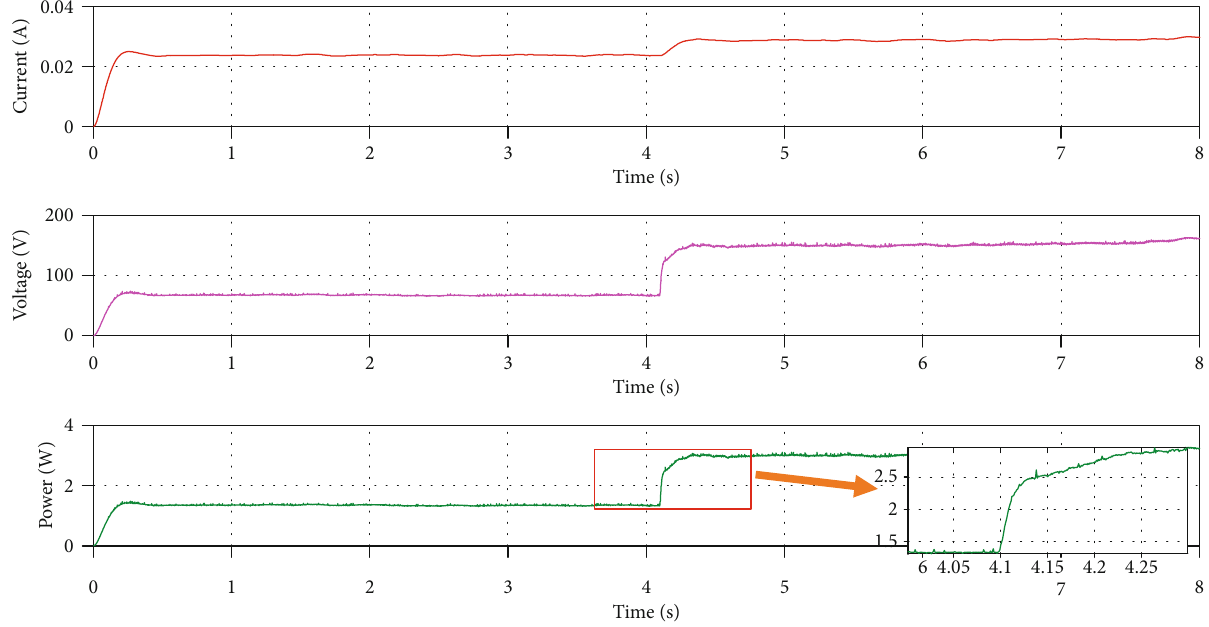
Figure 21: Experimental results (current, voltage, and power) of the MPPT controller based on conventional ESC.